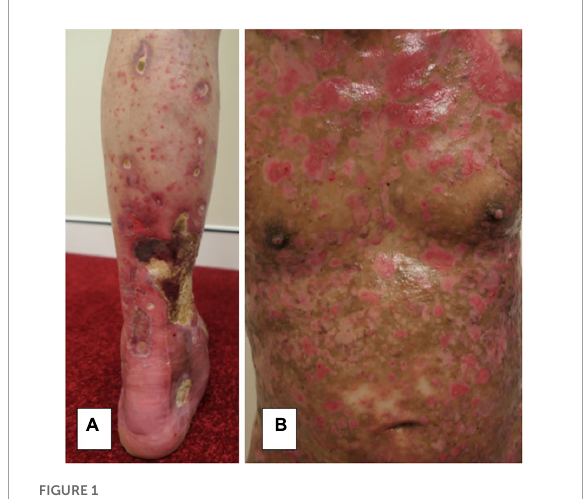
FIGURE1 (A) Severe lower limb necrotic ulceration secondary to IgA vasculitis from severe bullous pemphigoid induced by a COVID-19 vaccination with (B) extensive activity and damage